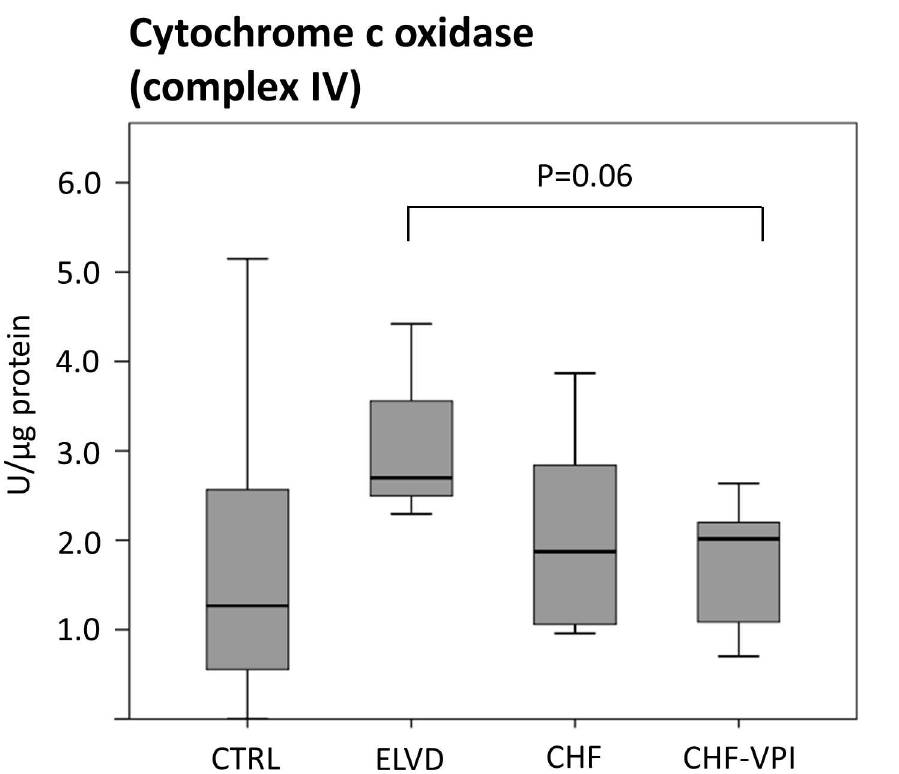
Fig 8. Enzymatic activity of cytochrome c oxidase (ETC complex